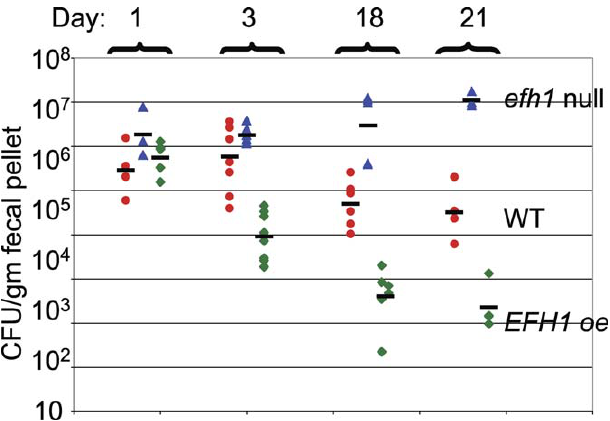
Figure 4. Attenuated Colonization of Mice by an EFH1 Overexpressing Strain Cells of WT strains CKY363 or DAY185, efh1 deletion mutant strain CKY366, and EFH1 overexpressing strain CKY364 were orally inoculated by gavage. At various days post-inoculation, fresh fecal pellets were recovered from inoculated mice and the amount of C. albicans per gm was measured. Red circles, CKY363 or DAY185 (WT) (seven mice); blue triangles, efh1 deletion mutant strain CKY366 (six mice); dark green diamonds, CKY364 ( EFH1 overexpressing) (eight mice); bars, geometric means. Composite results of two experiments are shown. Different numbers of mice are shown on different days because some mice were sacrificed earlier and some mice were sampled on different days.